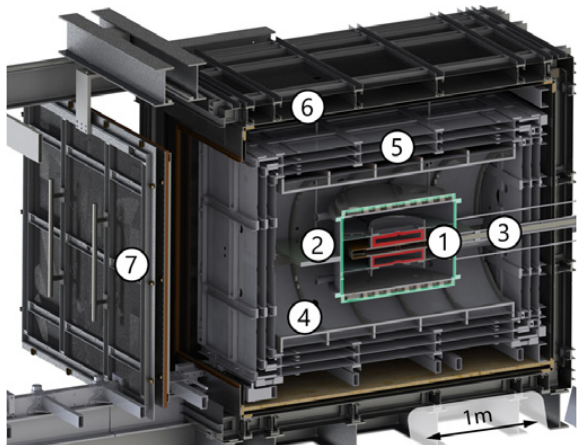
Figure 4. PanEDM magnetic shields and central components. 1: UCN cells, 2: vacuum chamber, 3: high-voltage insertion, 4: cylindrical shield and field coils (not shown) for B 0 and B 1 , 5: three-layer inner magnetic shield (Insert), 6: outer magnetic and RF shield (MSR), 7: MSR